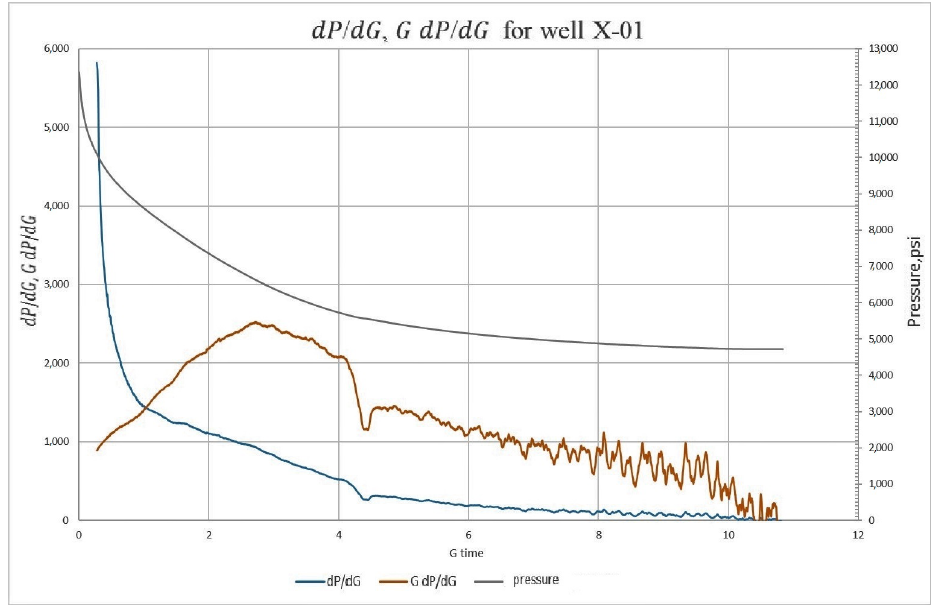
Figure 22. Tangentmethod (dP/dG and GdP/dG) for well X-01.